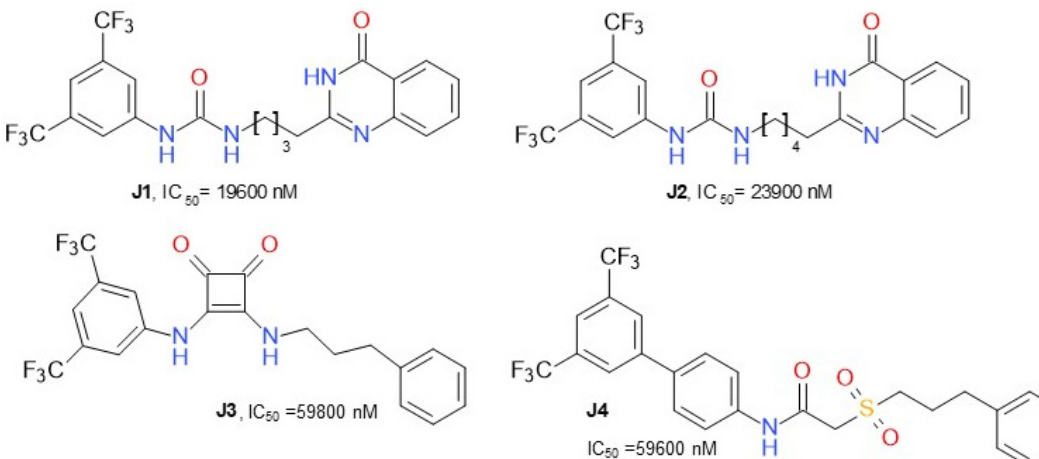
Figure 12. Reversible MAGL inhibitors—various structures.